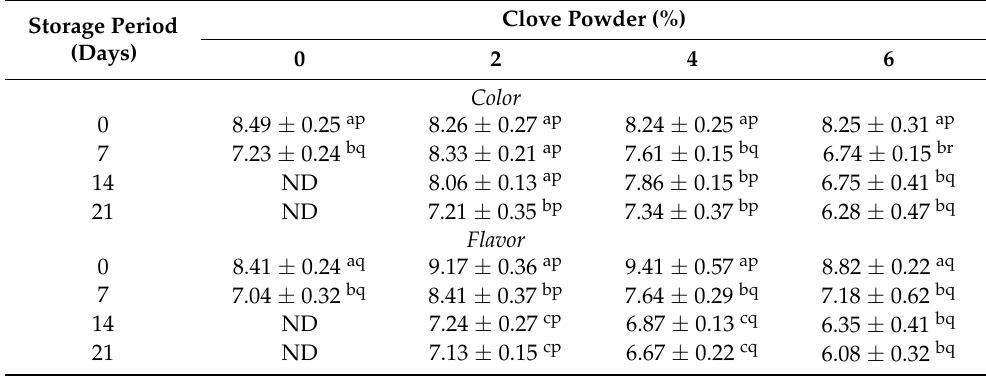
Table 5. Sensory properties of cooked beef burger formulated with different concentrations of clove powder during storage at 4 ◦ C ( ±